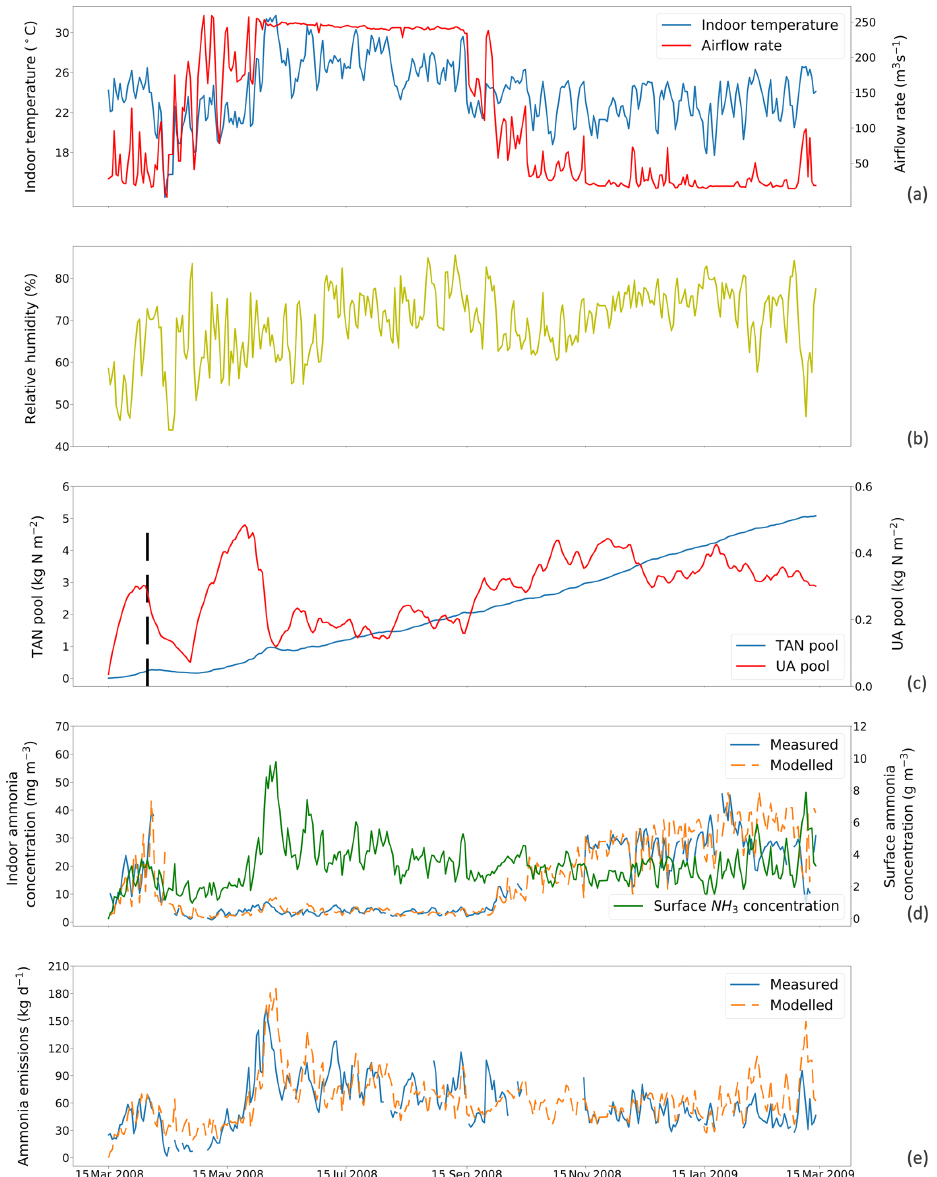
Figure 4. Site simulations using a fixed resistance ( R ∗ ) value of 16700sm − 1 for House A at site NC2B, Nash, North Carolina, from 15 March 2008 to 15 March 2009. (a) Measured daily mean indoor temperature and airflow rate of the house. (b) Measured daily mean relative humidity of the house. (c) Modelled TAN pool and UA pool. The black dashed line indicates the house-emptying date of 9 April 2008. (d) Comparison between measured and modelled indoor NH 3 concentrations of the house and surface NH 3 concentrations. (e) Comparison between modelled NH 3 emissions and calculated NH 3 emissions from measured indoor concentrations. The simulation illustrated uses the new parameterization (based on the AFO data; Fig. 3) for the relative humidity dependence of UA